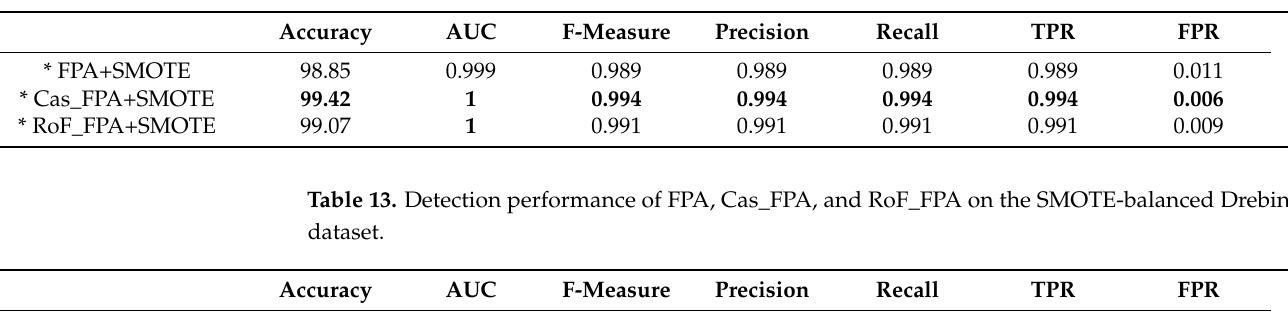
Table 12. Detection performance of FPA, Cas_FPA, and RoF_FPA on the SMOTE-balanced Malgenome dataset.